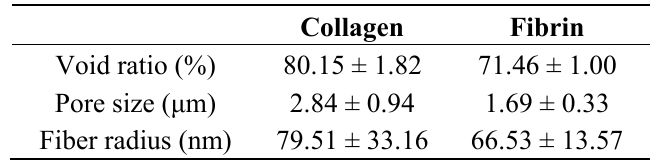
Table 1. Microstructural characteristics of the hydrogels †